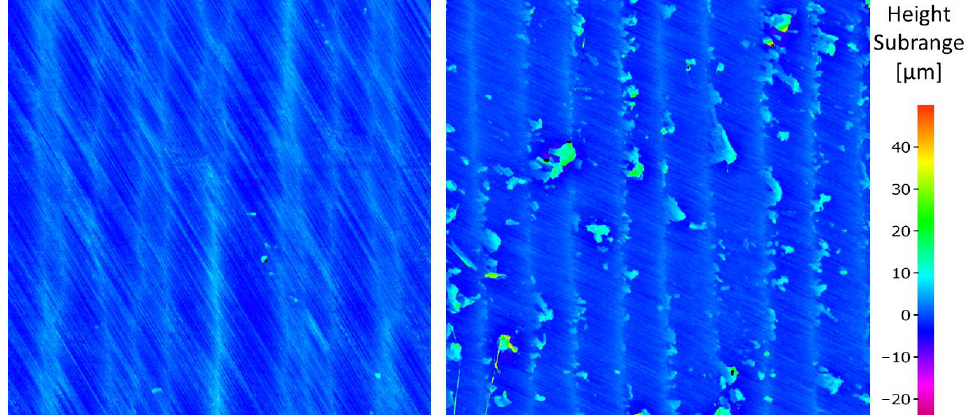
Figure 9. The final state of the machined surface of the Ti-6Al-4V material. Experiment No. 7 ’ s process parameters, when combined with the rotary monolithic cutting tool, resulted in a stable machining process. There were no critical points on the machined surface and the machined surface was characterized by a regular texture. The chips were bonded to the machined surface in experiment No. 10. This results in the cre- ation of protrusions on the surface and increases the values of the roughness parameter Rz. This phenomenon occurred mainly at the workpiece rotation speed ( v w ) set at the up- per limit of the range and, at the same time, the low tool rotation speed ( v t ). The measured values of the roughness parameter Rz are graphically shown in Figure 10.